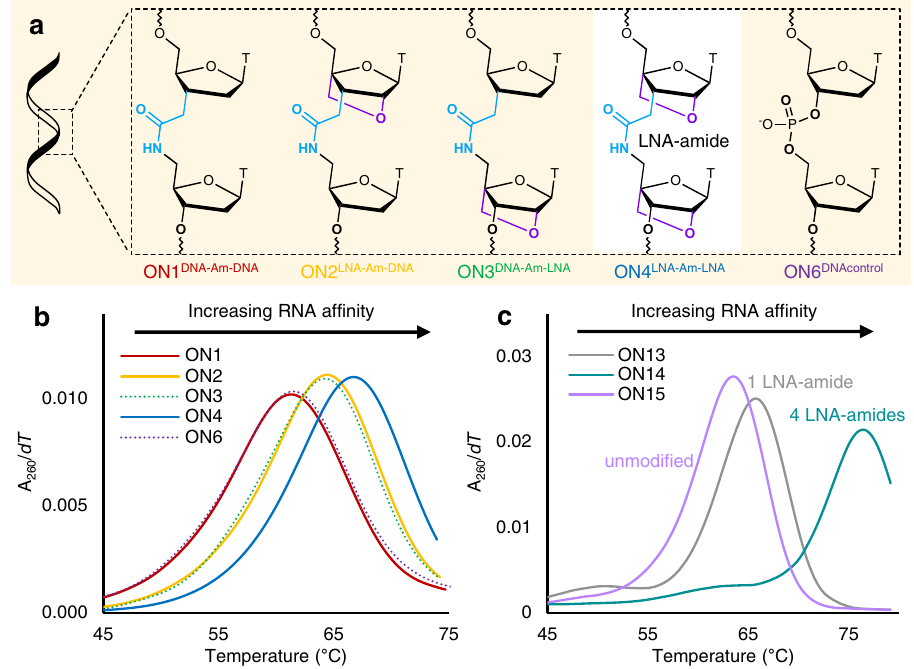
Fig. 4 Combining LNA and AM1 increase af fi nity for complementary RNA. a The structures of each of the LNA AM1 combinations studied. Sequence d-CGACGC TT GCAGC (where the underlined region indicates the modi fi cation position) b UV-melting curve derivatives of the ONs from panel a in duplexes with complementary RNA. c UV-melting curve derivatives demonstrate that the stabilisation conferred by the LNA-amide linkage against complementary RNA is general and cumulative. Conditions: 10 mM phosphate buffer, 200 mM NaCl, pH 7.0. Sequences in Supplementary Table